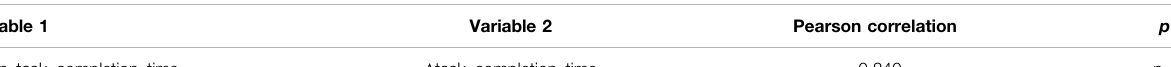
TABLE 2 | Pearson correlations between variables in RUI VR. Variable 1 Variable 2 Pearson